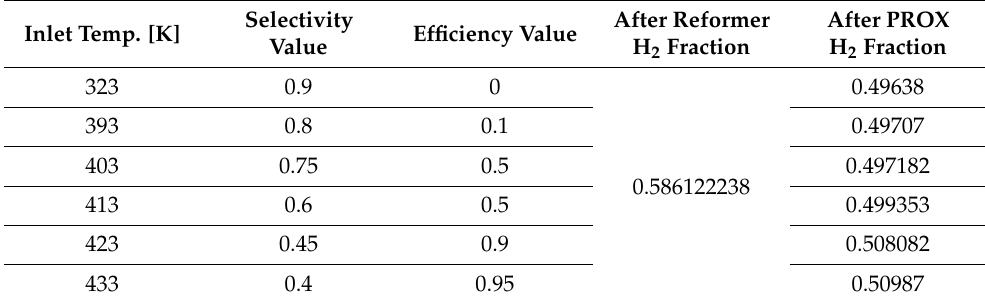
Table 4. Fraction of hydrogen according to η (1 −